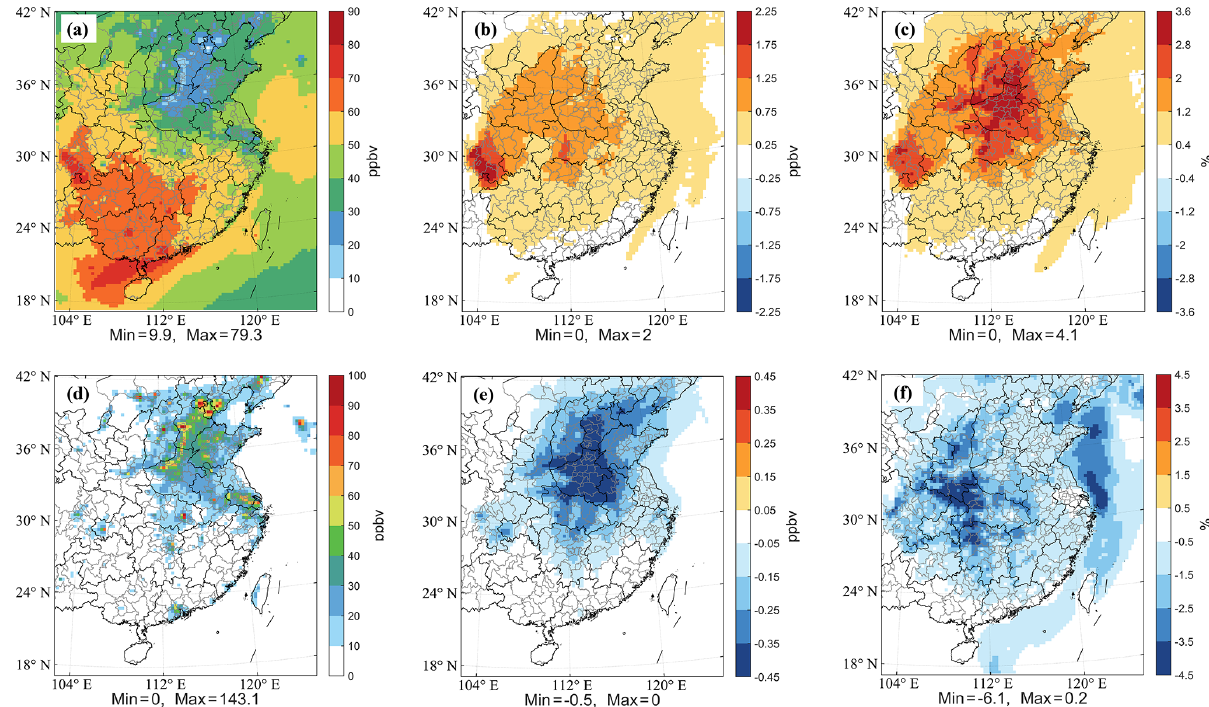
Figure 8. Spatial distributions of modeled daily maximum 8h O 3 (a) and NO x (d) average concentrations in November 2011 in the Base experiment; the differences (Base minus NoCl) of modeled daily maximum 8h O 3 (b) and NO x (e) average concentrations in November 2011; the percent changes of the Base experiment to the NoCl experiment of modeled daily maximum 8h O 3 (c) and NO x (f) average concentrations in November 2011.